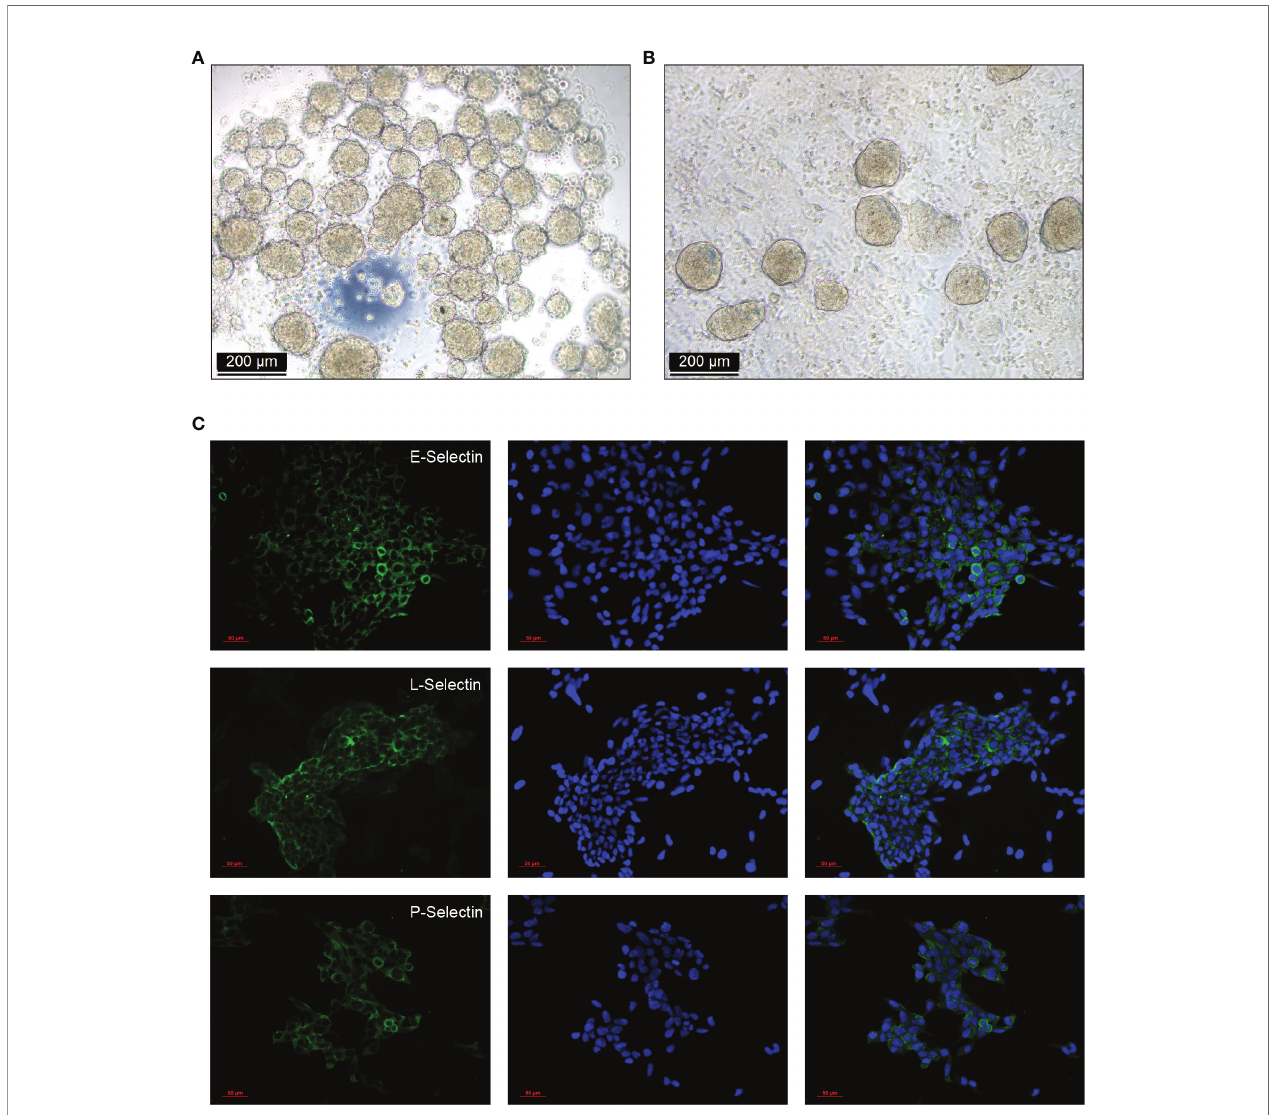
FIGURE 5 | Spheroids formation, adhesion, and selectins expression in HTR-8/SVneo cells. (A) HTR-8/SVneo cells spheroids were created with the modi fi ed hanging drops method, 2×10 4 cells per 30 µL drop supplemented with regular culture medium were plated onto the lid of Petri dishes (40 drops/Petri lid). Plenty of spheroids were formed after 20 h culture. (B) Cell strainer selected spheroids (100 - 200 µm) were gently transferred onto each well of con fl uent RL95-2 cells in 8- well chamber slides, and co-cultured for 2 h for adhesion. (C) Expression of Lewis antigens putative ligands E, L, and P selectins in HTR-8/SVneo cells detected by immuno fl uorescent